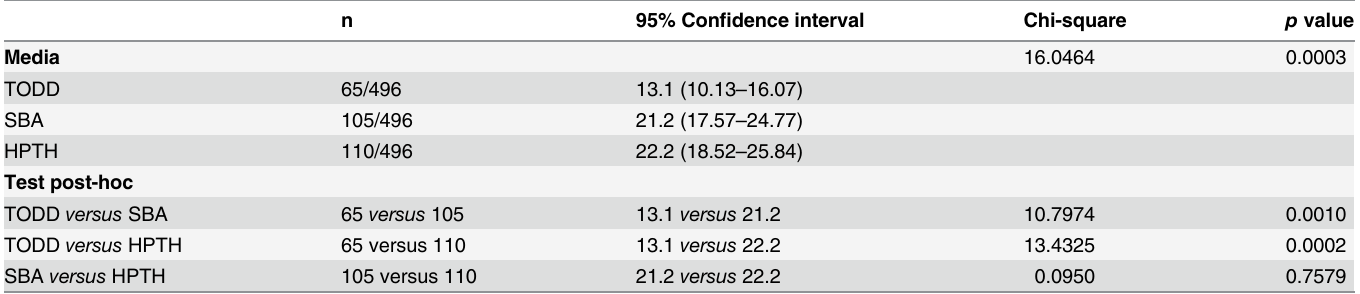
Table 2. Comparison of Streptococcus agalactiae detection by Todd-Hewitt enrichment broth (TODD), sheep blood agar (SBA), and Hitchens- Pike-Todd-Hewitt (HPTH) culture media in pregnant women at 35 – 37 weeks of gestation. n 95% Con fi dence interval Chi-square p